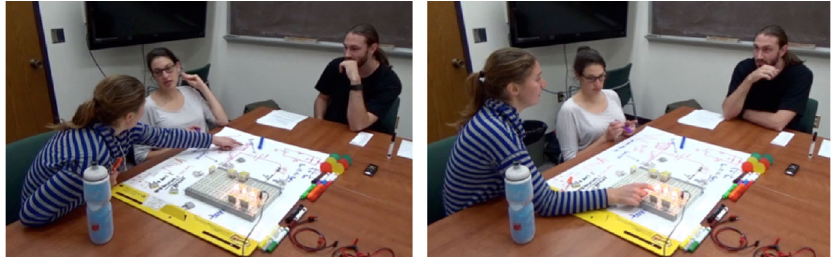
FIG. 3. Student body position and gaze in the sensemaking frame (left) vs the expert interview frame (right).